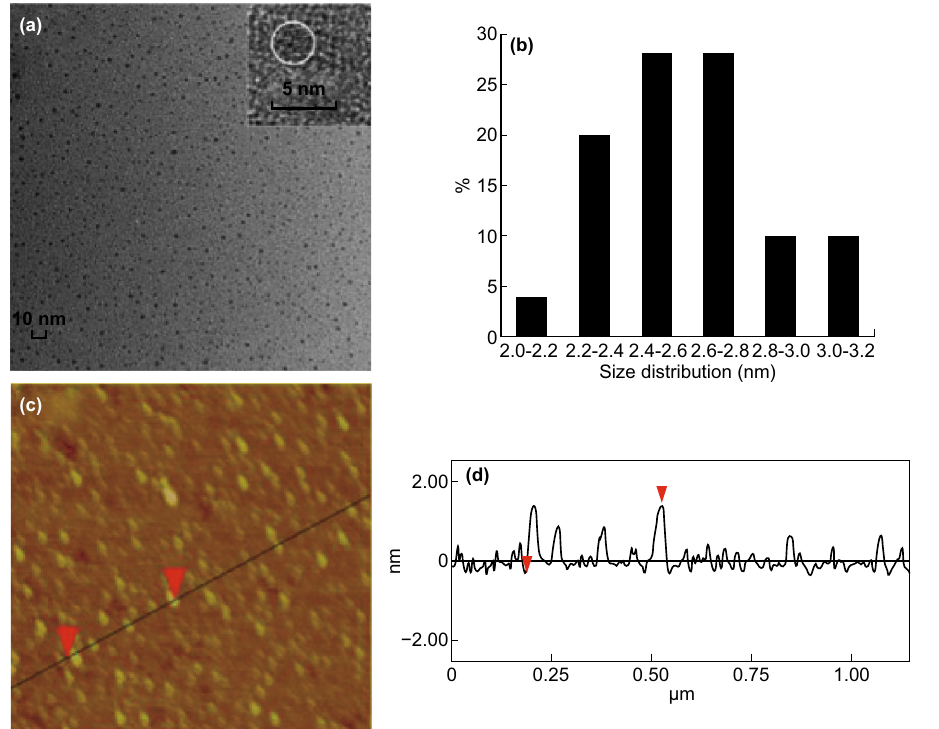
Fig. 4 a TEM images, b size distribution, and c , d AFM image and profile of CDs [78]. Copyright (cid:2) 2015 Elsevier